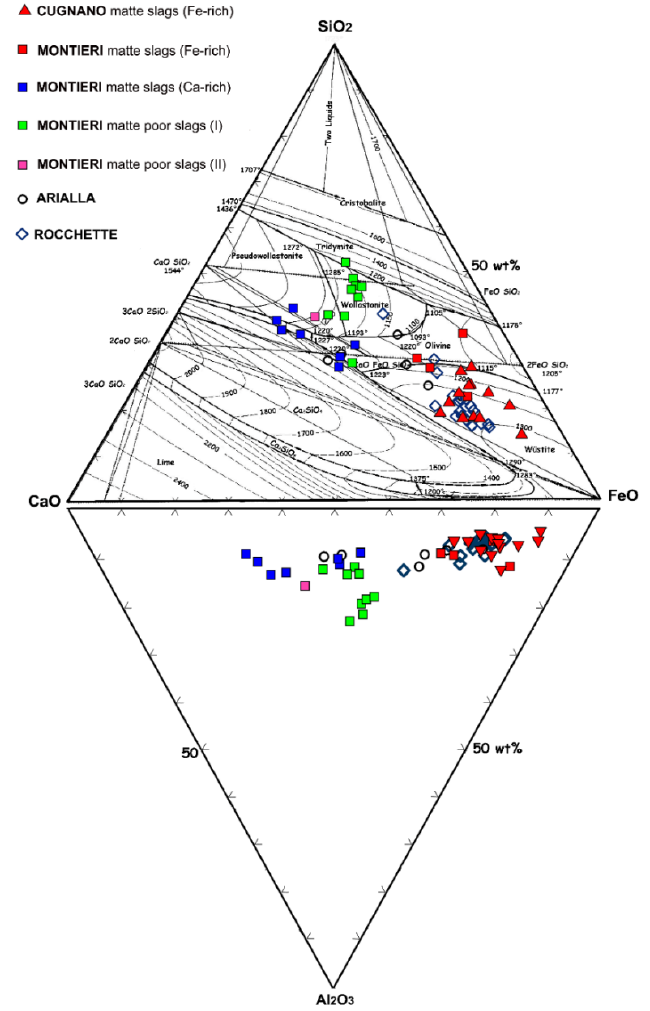
Figure 9. Chemical composition of slags into CaO-SiO 2 -FeO (after Osborn and Muan [32]) and CaO-Al 2 O 3 -FeO diagrams (composition as wt%).